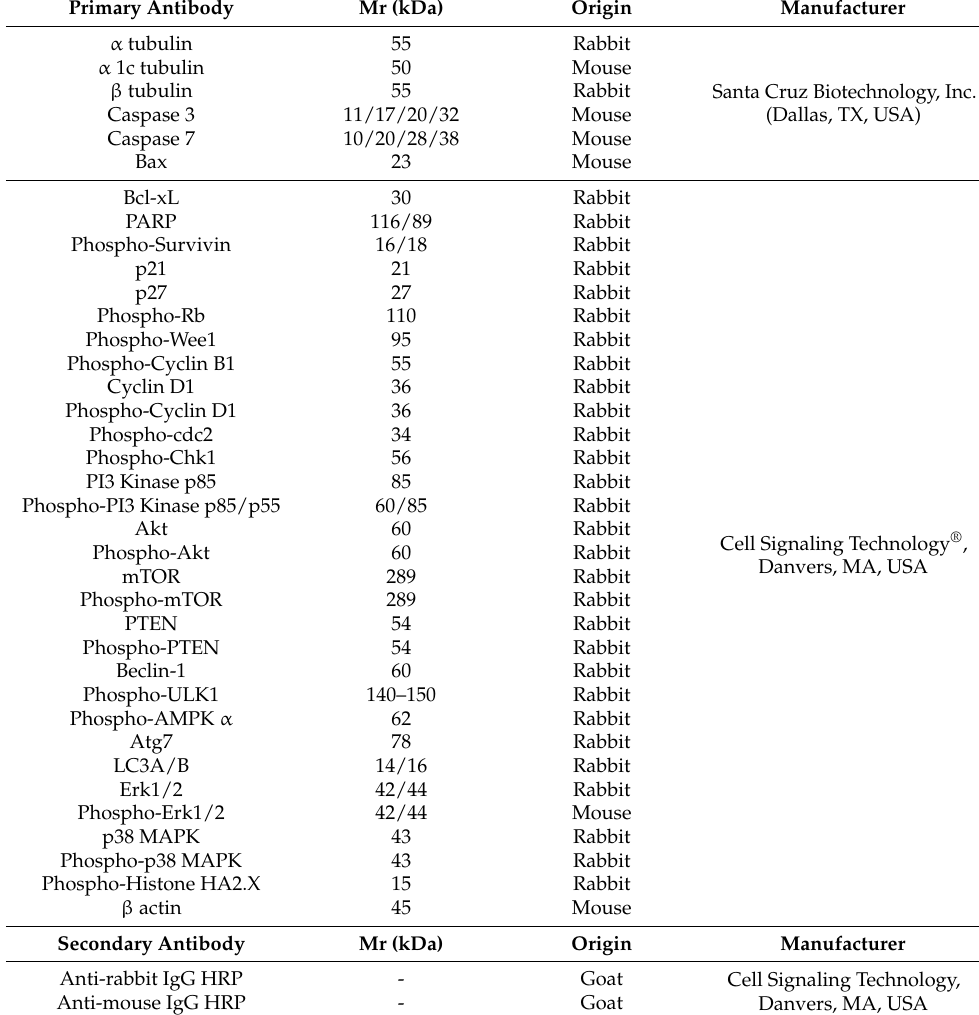
Table 2. List of Western blot